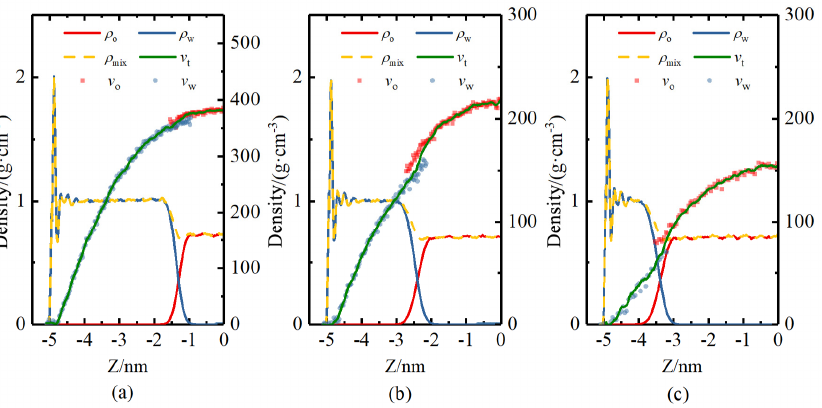
Figure 7. The velocity distributions of oil–water in 10 nm quartz nanopores with various OMP: ( a ) OMP = 20%; ( b ) OMP = 40%; ( c ) OMP =